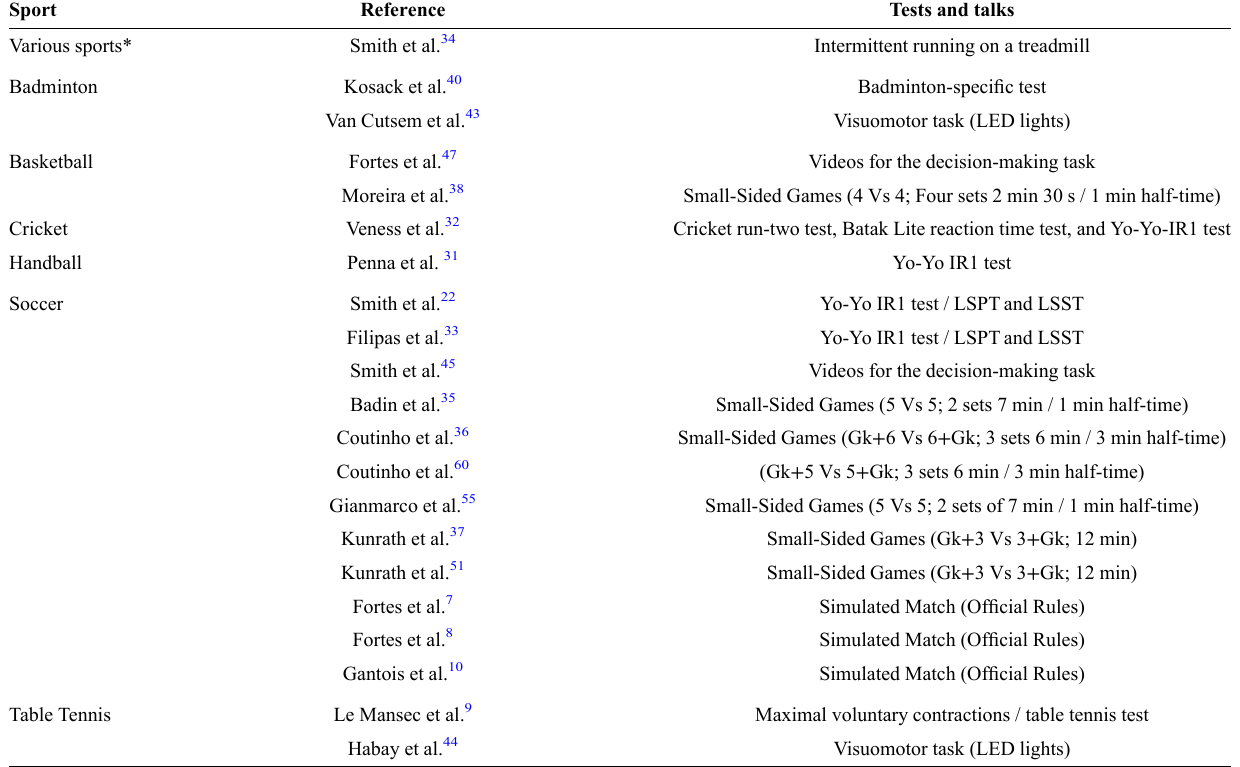
Table 2 - Tests and tasks performed by athletes organized by sport.